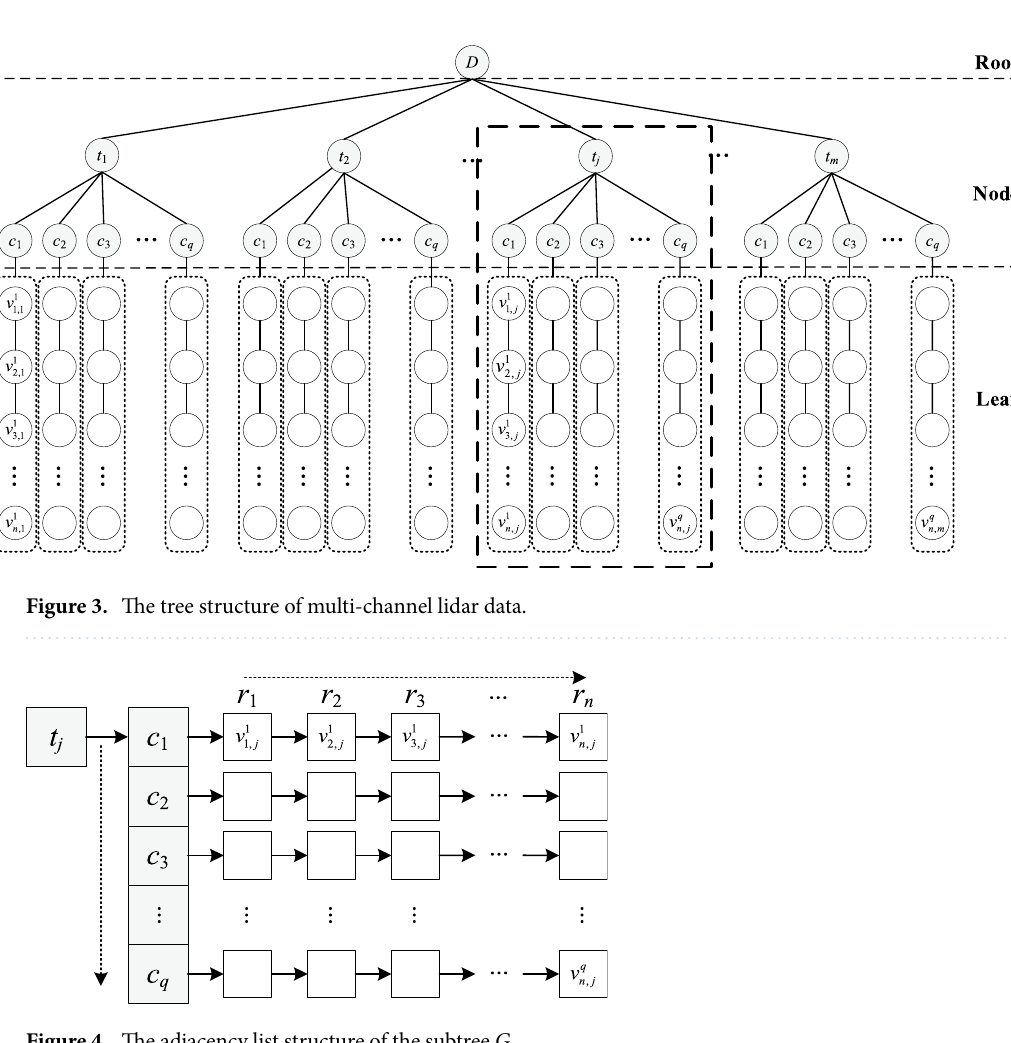
Figure 4. The adjacency list structure of the subtree G j